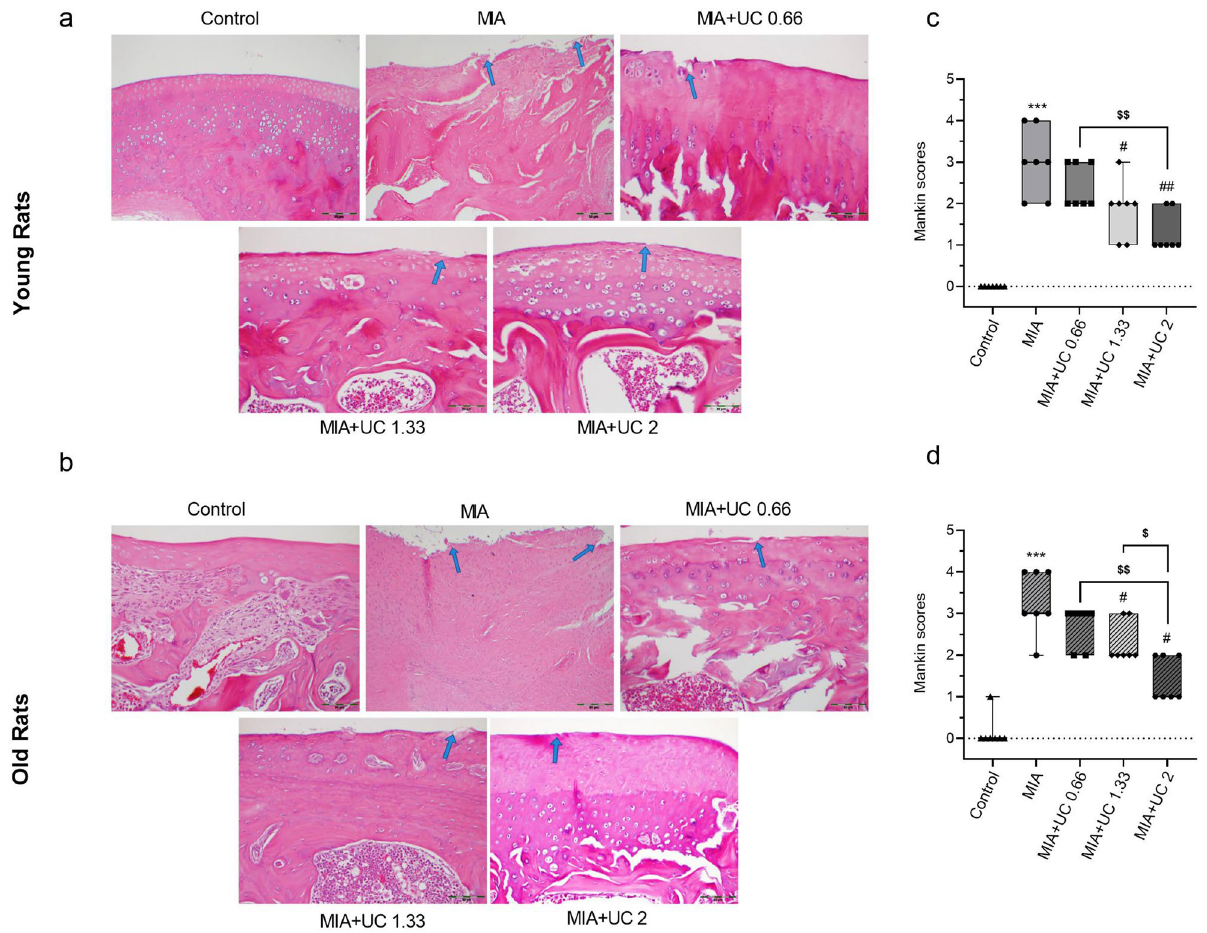
Figure 4. Effects of undenatured collagen (UC) supplementation at different doses on histopathology of the knee joint in monosodium iodoacetate (MIA) induced osteoarthritis in young (n = 7) and old (n = 7) rats. Representative histopathologic images of hematoxylin–eosin staining (H&E × 200, a : Smooth intact surface in the control group, pannus/surface fibrillation, clefs into the transitional and radial zones in the MIA group (blue arrows), mild fibrillation and clefs in MIA + UC 0.66 group (blue arrow), clefs in the MIA + UC 1.33 group (blue arrow) and slight clefs in the MIA + UC 2 were observed in young rats. ( b ): smooth intact surface in the control group, marked pannus/surface fibrillation, clefs into the transitional and radial zones in the MIA group (blue arrows), fibrillation and clefs in MIA + UC 0.66 group (blue arrow), mild fibrillation and clefs in the MIA + UC 1.33 group (blue arrow) and slight clefs in the MIA + UC 2 were observed in old rats. The depicted box ‐ and ‐ whisker plots represent Mankin scores ( c for young rats and d for old rats) with min and max values. Kruskal Wallis and Mann–Whitney U comparisons test were used to compare the results among different treatment groups. Statistical significance between groups is shown by: *** p < 0.001 (MIA vs. Control), and # p < 0.05; ## p < 0.01 (MIA vs. UC groups), and $ p < 0.05; $$ p < 0.01 (pairwise comparisons between UC collagen markedly suppressed the serum IL-1β, IL-6, PGE2, TNF-α, and COMP levels in a dose-dependent manner (Fig. 5). Overall, 2 mg/kg of undenatured collagen was more effective than 0.66 mg/kg in reducing all inflammatory markers in both age groups. Western blot analysis. MIA-induced knee OA caused inflammation as indicated by elevated expression levels of IL-1β, IL-6, IL-10, TNF-α (Fig. 6a–d), COX-2, NF-κB, MMP-3, and COMP (Fig. 7a–e) proteins in the knee joint cartilage of both young and old rats (p < 0.0001). Additionally, knee joint CTX-II and TGF-β levels were lowered in the MIA rats of both age groups (p < 0.0001). We found that undenatured collagen treatment ameliorated the expression of most inflammatory cytokines in a dose-dependent manner in both young and old rats (Fig. 6 and Fig. 7, p < 0.001). More specifically, the protein level of NF-κB, MMP3, and COMP in the knee joint was reduced in a dose-dependent manner by undenatured collagen compared with the MIA group (Fig. 7b, d and e, p< 0.001). In young rats, knee joint CTXII and TGF-β proteins were significantly improved with the 2 mg/kg dose vs. The 0.66 mg/kg dose (p < 0.001). On the other hand, in the old age group, there was a dose-dependent effect of undenatured collagen for these markers (p < 0.0001 for Collagen type 2 and p < 0.01 for TGF-β). We also found that 1.33 and 2 mg/kg undenatured collagen similarly reduced knee joint protein